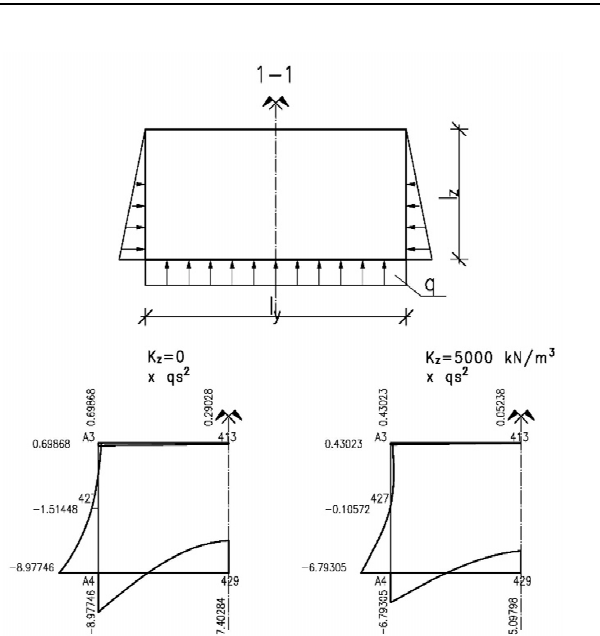
Figure 5. Charts of bending moments due to the hydrostatic load of the walls and the uniform load of the bottom without taking into account the effect of an elastic substrate and for the Poisson’s ratio ν = 0 and taking into account the effect of an elastic substrate K = 5000 kN/m 3 and for the Poisson’s ratio ν = 0 in cross section 1–1 (Figure 4).